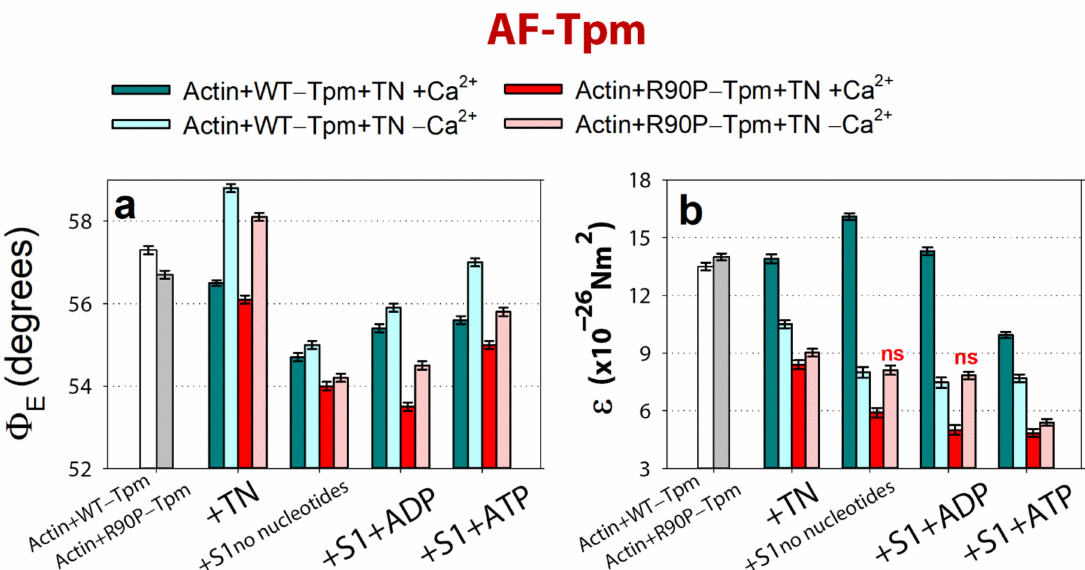
Figure 4. The effect of troponin (TN) and Ca 2+ on the values of Φ E ( a ) and ε ( b ) of the polarized fluorescence for 5-IAF linked with the WT-Tpm and R90P-Tpm, revealed in ghost fibers under conditions simulating the sequential steps of the actomyosin ATPase cycle. The values of Φ E were corrected in order to take into account the changes in the conformation of Tpm strands. The first and second entries from the left in each panel present the data obtained in the absence of S1. The data represent the mean values for 5–7 fibers for each experiment (see Materials and Methods). The Φ E and ε values in the absence and in the presence of nucleotides are significantly altered by TN and Ca 2+ for both WT-Tpm and R90P-Tpm ( p < 0.05). Mark “ns” indicates unreliable differences in the values of ε between the WT and mutant Tpms. Error bars indicate ± SEM. The values of N are close to